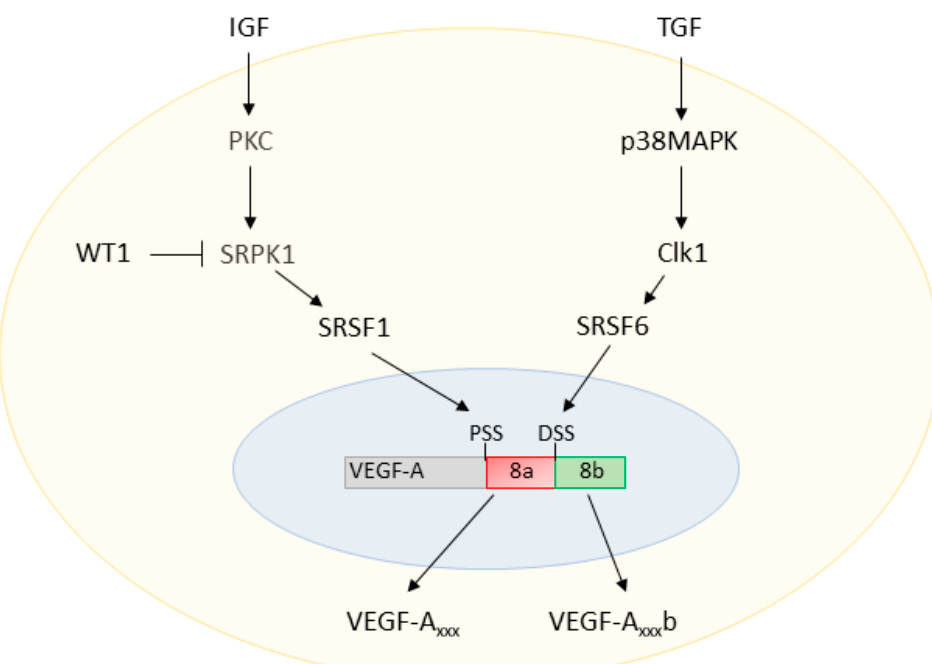
Figure 2. VEGF-A splicing regulation. Insulin-like growth factor (IGF) activates protein kinase C (PKC), which in turn phosphorylates SR protein kinase 1 (SRPK1). Activated SRPK1 can then shuttle the splice factor Serine/Arginine Rich Splicing Factor 1 (SRSF1) to the nucleus, resulting in proximal splice site (PSS) selection in exon 8 of VEGF-A. The transcription factor Wilms Tumor 1 ( WT1 ) inhibits the synthesis of SRPK1, downregulating PSS selection. On the other hand, transforming growth factor (TGF) signalling activates p38 mitogen-activated protein kinases (p38MAPK), which then activate cell division cycle (CDC)-like kinase 1 (Clk1). Activates Clk1 causes shuttling of the splice factor SRSF6 to the nucleus, resulting in distal splice site (DSS) selection.